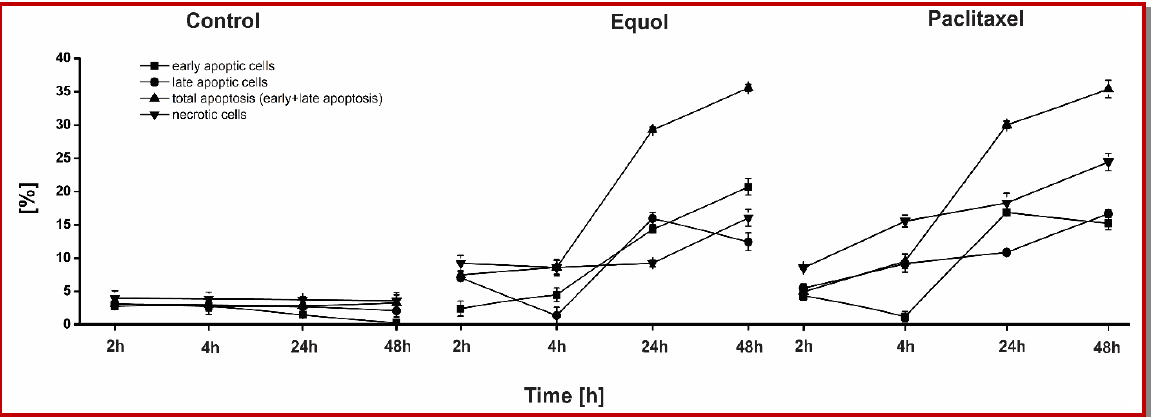
Figure 3 : Fraction of the cells in early and late apoptosis and necrosis at different time points following the treatment of SKOV-3 cells with IC 50 concentration of equol and PTX. Results are presented as means ± S.D. of four experiments